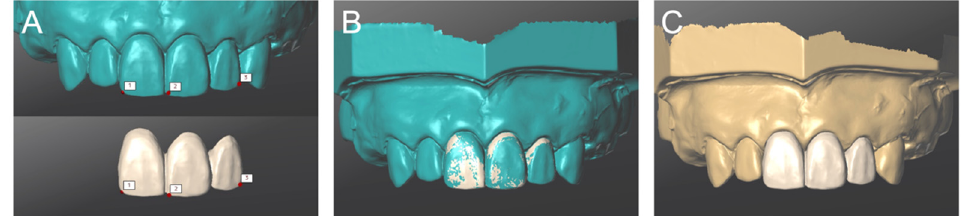
Figure 5. ( A ) After determining three points as reference points, Data 1 (Figure 4A) and Data 3 (Figure 4C) were superimposed. ( B ) Two data (Data 1,3) were superposed. ( C ) Finally, Data 2 (Figure 4B) was superposed.